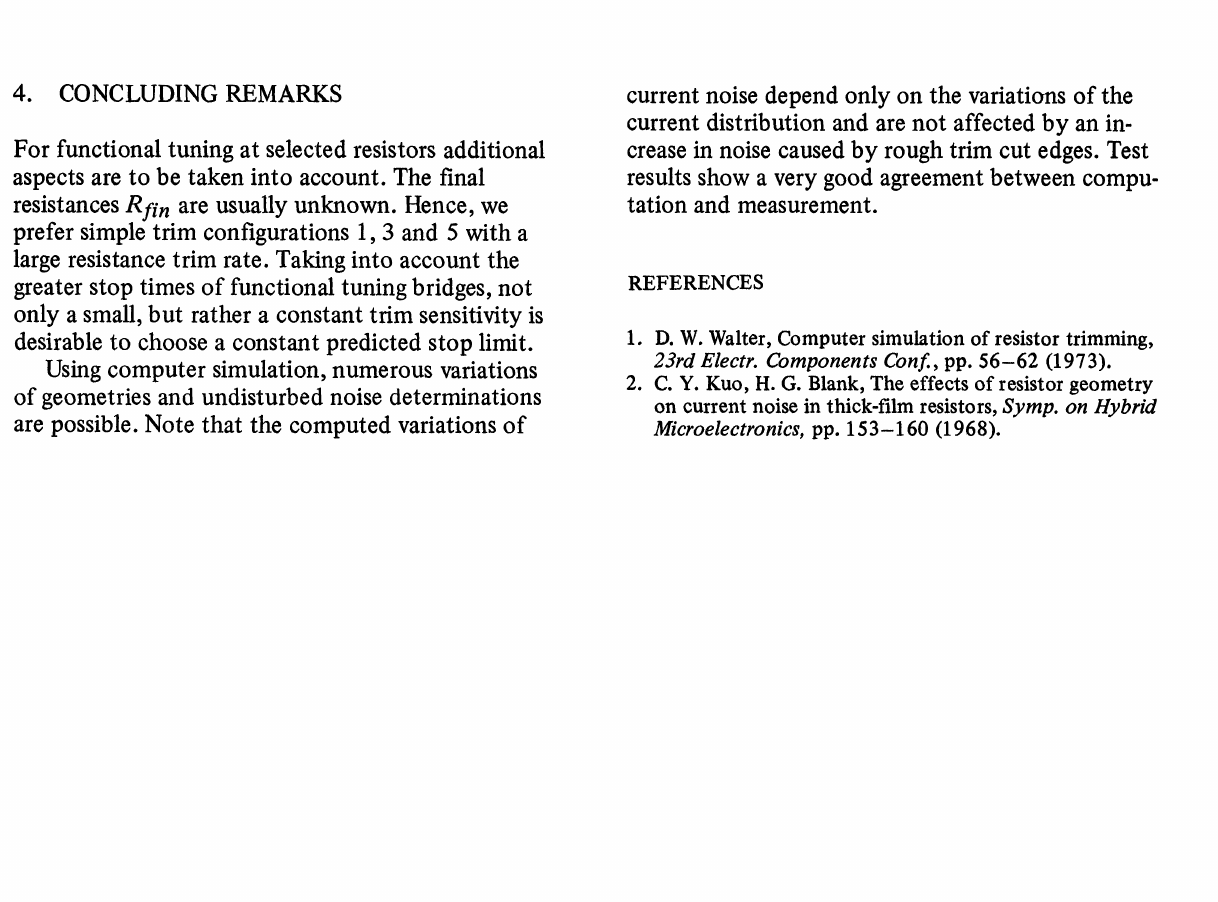
FIGURE 9 Design rules.